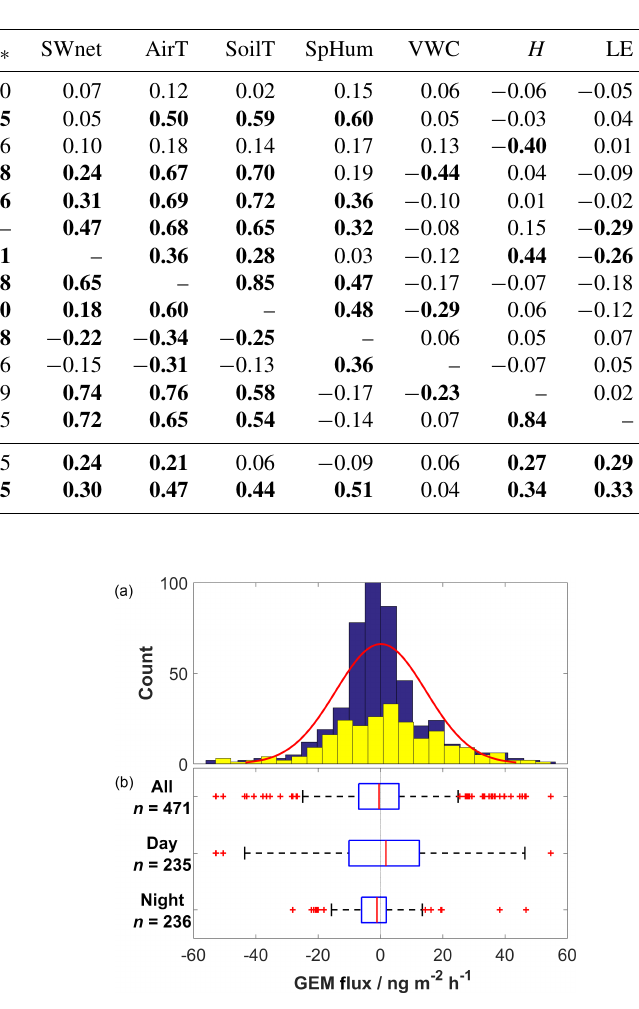
Table 1. Correlations between hourly averaged flux and measured environmental variables. The top right triangle represents nocturnal data ( n = 102); the bottom left triangle represents diurnal data ( n = 128). The bottom two rows represent correlations using all data ( n = 230). Bold type represents significance at p < 0 . 05. Abbreviations are as follows: GEM_f: GEM flux (ngm − 2 h − 1 ); CO 2 _f: CO 2 flux